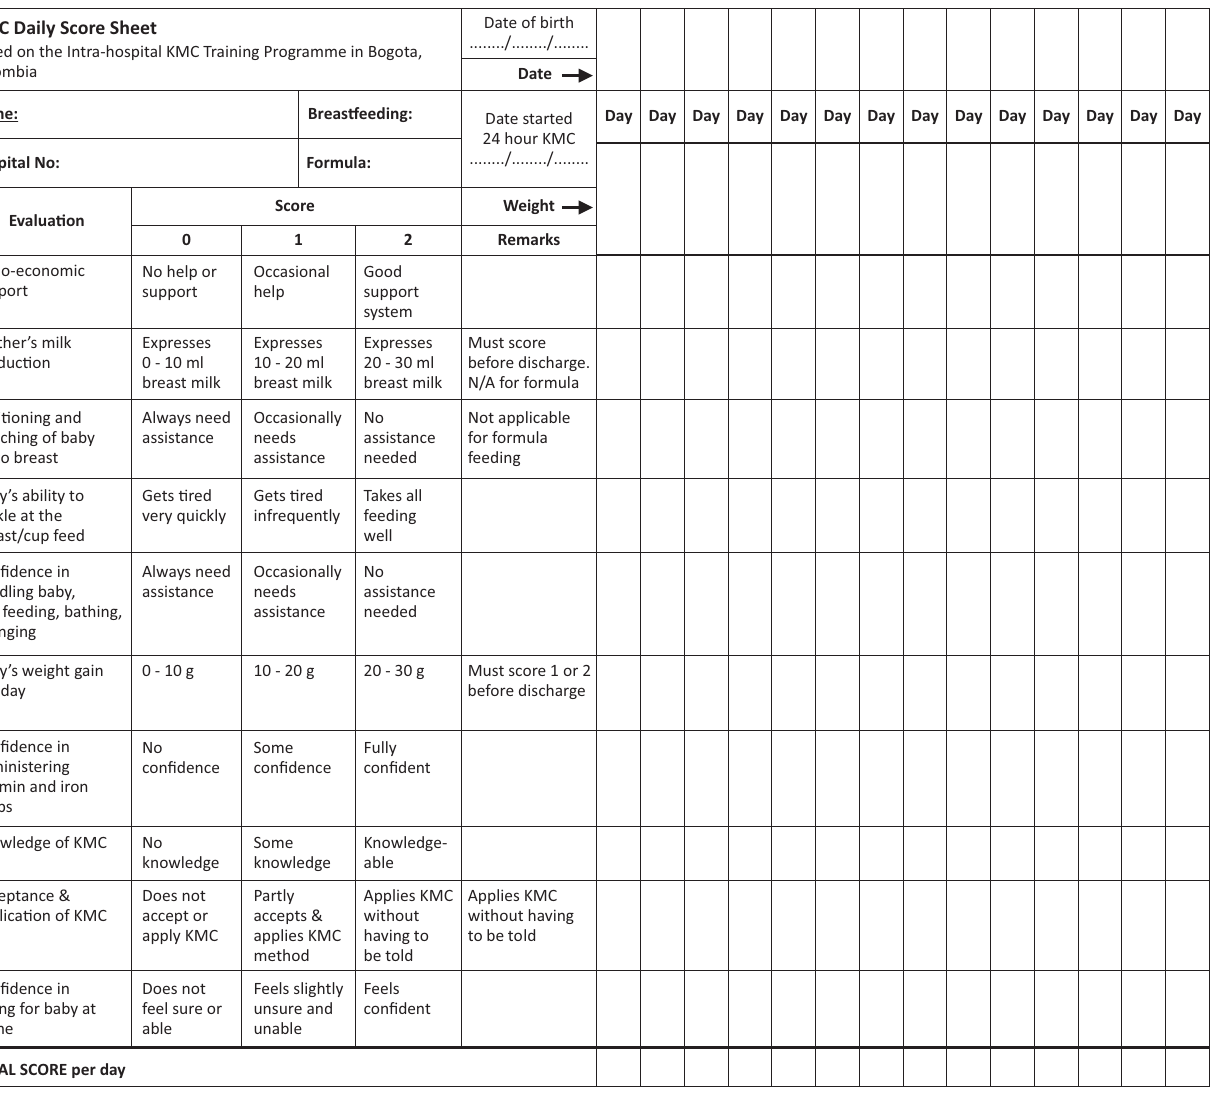
FIGURE 1: Kangaroo mother care daily score